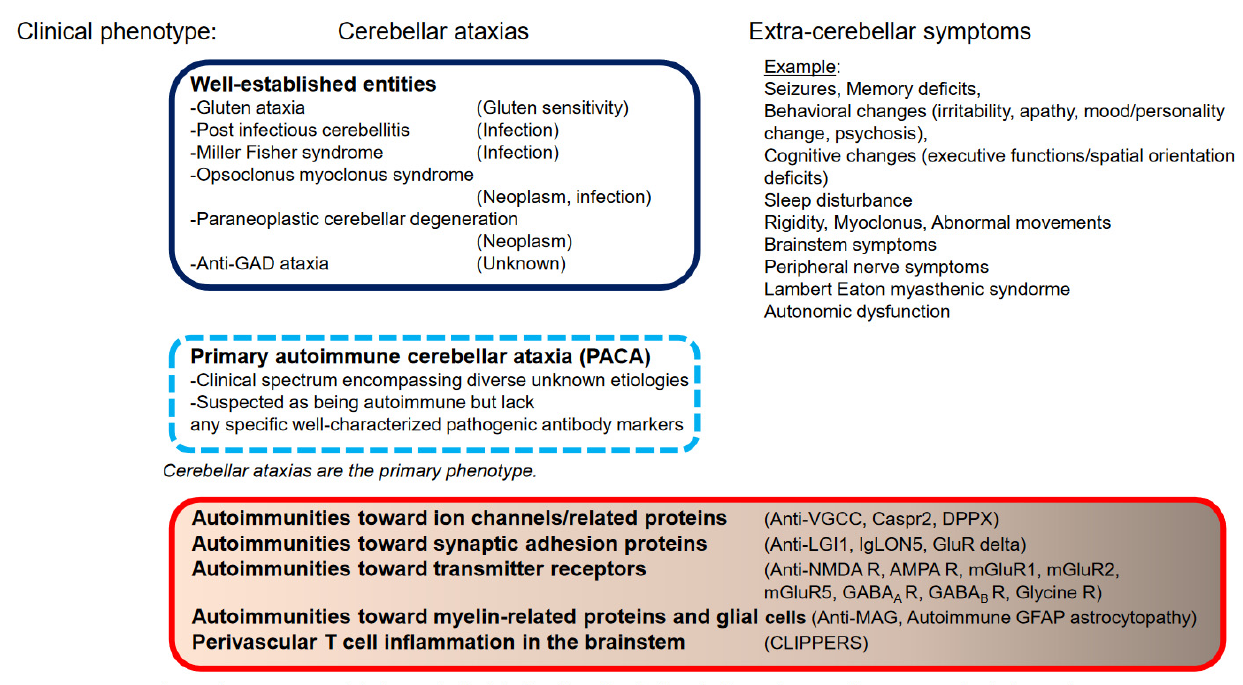
Figure 1. A schematic diagram of the diverse etiologies in immune-mediated cerebellar ataxias. In case of well-establish etiologies, cerebellar ataxia is the primary presentation. Primary autoimmune cerebellar ataxia (PACA) encompasses etiologies associated with poorly characterized nonpathogenic antibodies. By contrast, cerebellar ataxia can be one of many neurological presentations in autoimmunity towards ion channels and related proteins, synaptic adhesion molecules, transmitter receptors, and glial cells, or in T-cell inflammation in the brainstem. In some cases, ataxia may be